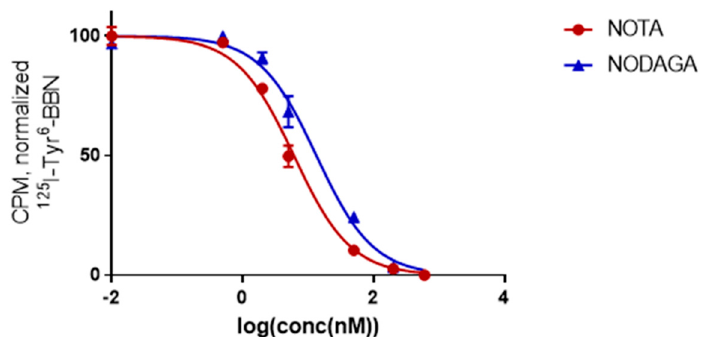
Figure 4. Inhibition of 125 I-Tyr 4 -BBN binding to PC-3 cells with nat Cu-X-RM26 [X = NOTA-PEG 2 ( ● ) and NODAGA-PEG 2 ( ▲ )]. Data are presented as mean value ± standard deviation.